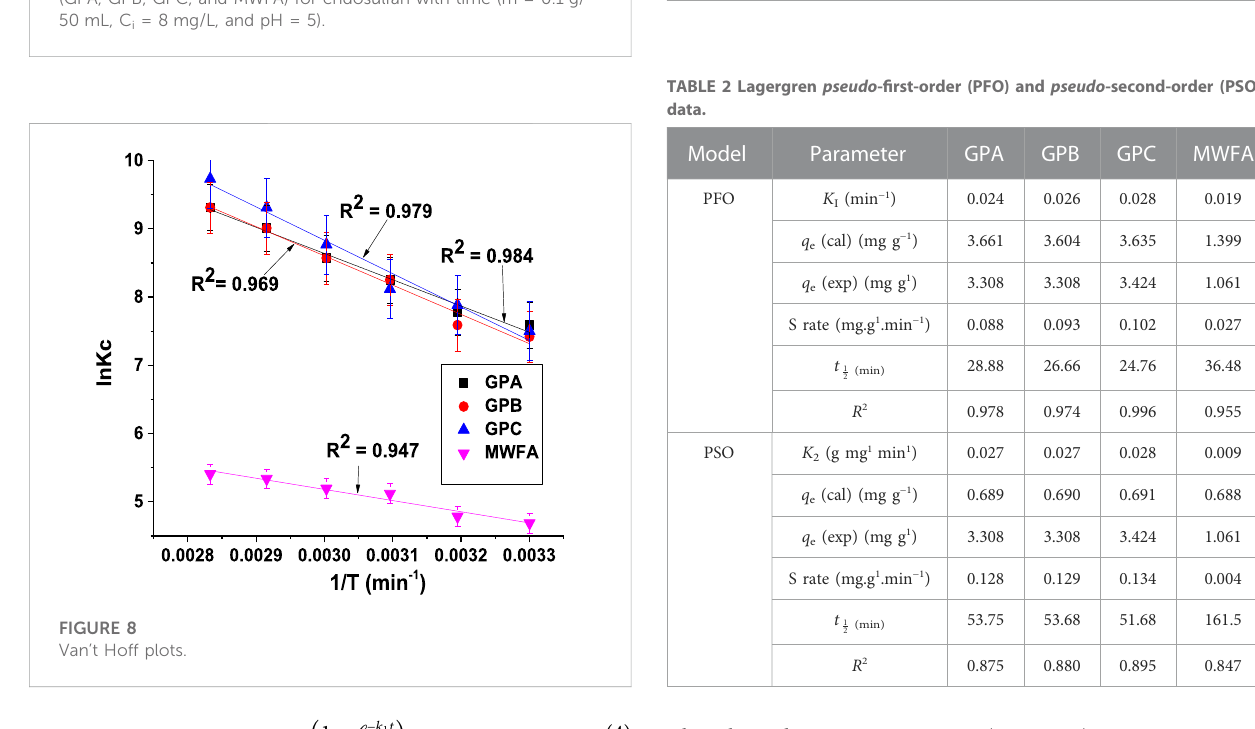
FIGURE 9 Arrhenius-type equation plots.